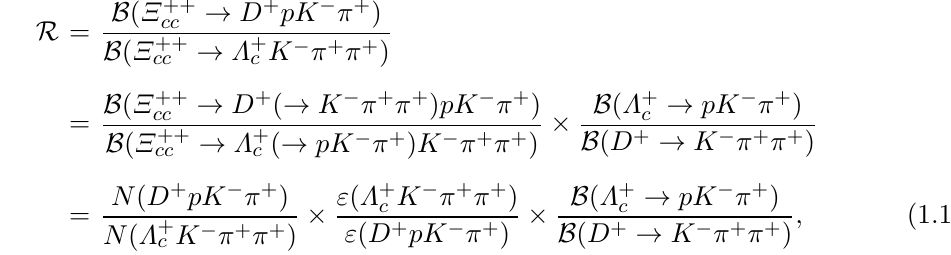
(cid:3) + K (cid:0) (cid:25) + (cid:25) + cc ! c